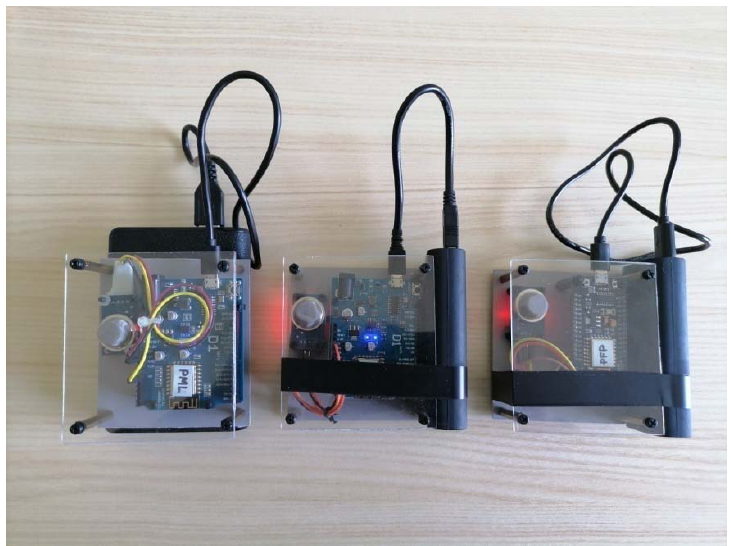
Figure 6. Three prototype sensor nodes: two Wemos D1 R2 (left and central), and one NodeMCU (on the right).